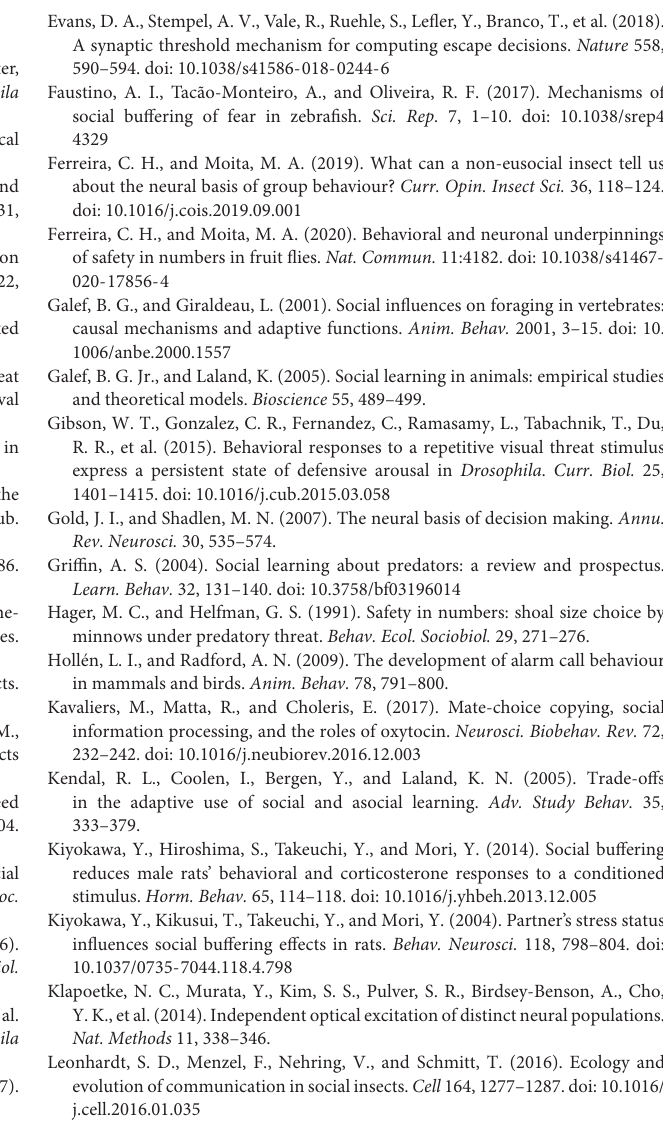
1.5 × interquartile range]. Average motion cues a focal fly is exposed to the stimulation period. P -value results from the two-tailed Mann–Whitney test. Supplementary Figure 3 | Freezing and jumping responses of optogenetically activated LC6 > CsChrimson. (A) Fraction of flies freezing throughout the experiment while providing pulsed red light at the timestamps normally used to provide looming stimuli (dashed lines); LC6 > CsChrimson flies supplemented with retinal (blue) and control without (gray). (B–D) We manipulated four out of the five flies in group, to surround focal flies with groups with different proportions of flies that always move (blind flies, NorpA) and flies that are optogenetically made to freeze (LC6 > CsChrimson), while presenting looming stimuli. The color code for the groups is presented in (B–D) . Fraction of surrounding, manipulated, flies freezing throughout the experiment when exposed to slow (B) or fast looming stimuli (C) ; dashed lines represent looming stimuli presentations. (D,E) Data from flies exposed to slow looms. (D) Number of jumps throughout the experiment by the surrounding manipulated flies. (E) Number of jumps at the first loom presentation for LC6 > CsChrimson flies in groups of four